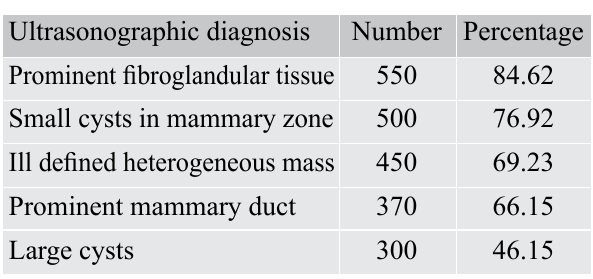
Ultrasonographic diagnosis